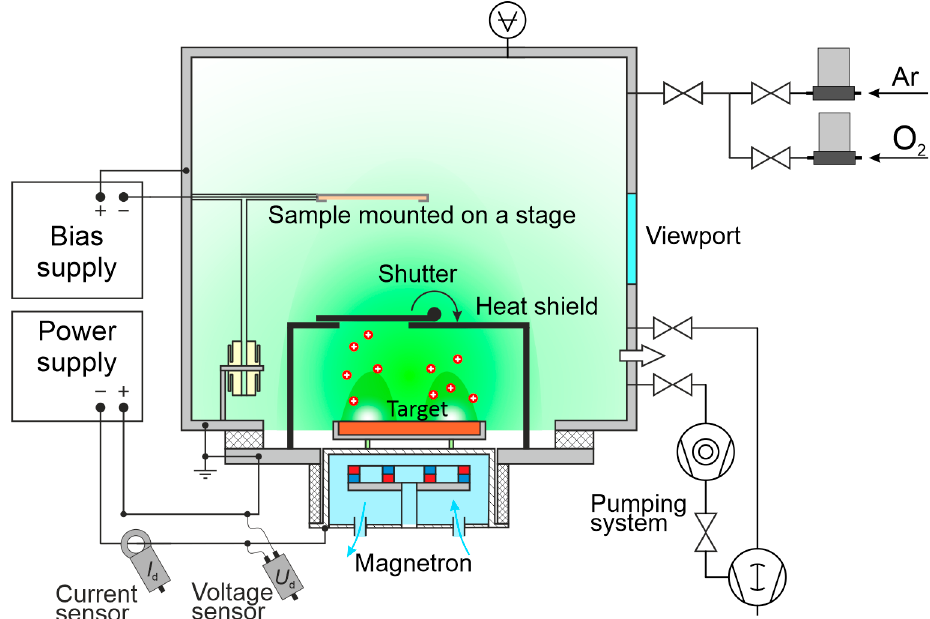
Figure 2. Hot-target magnetron deposition